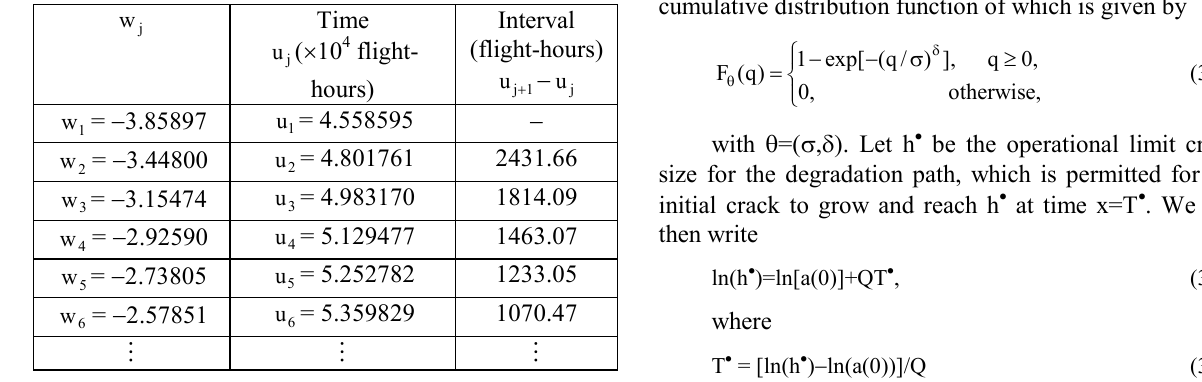
Table 2. The inspection time